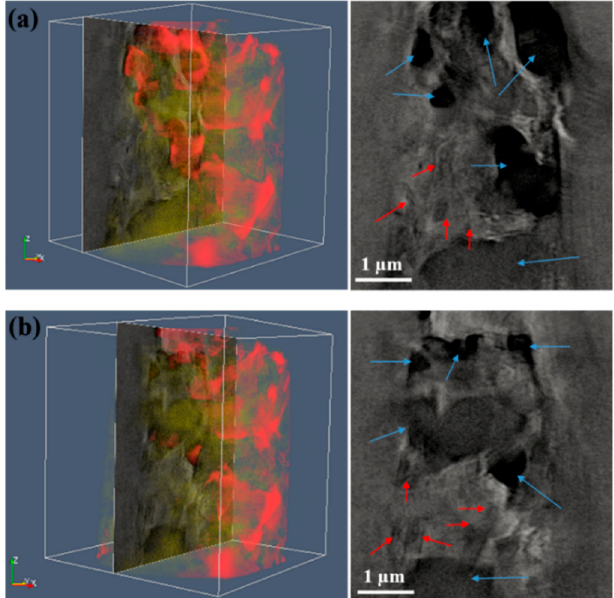
Figure 1. ( a , b ) Extracted slices from a volumetric reconstruction of the composite with 30 wt.% multilayer graphene (MLG) by synchrotron-based nano-X-ray computed tomography (XCT). ZrO 2 phases are indicated by blue arrows, Si 3 N 4 phases are indicated by red arrows.